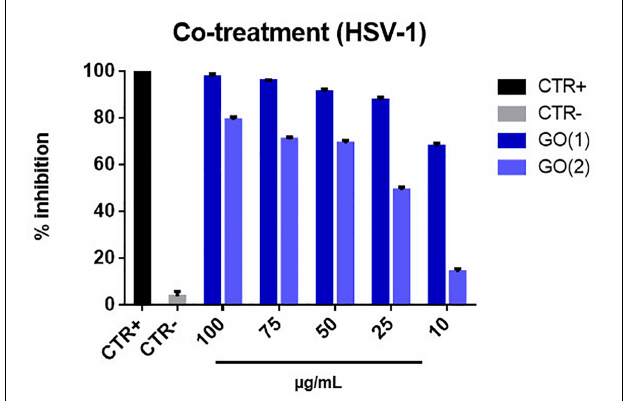
FIGURE 9 | Co-treatment with GO NSs. The graph shows the percentage of inhibition of viral infection after treatment with GO [GO(1) and GO(2)]. We remind that for GO(1) the average lateral size of the nanoflake is ≈ 175 nm whereas for GO(2) is ≈ 500 nm, the average thickness being ≈ 1.2 nm and ≈ 2.5 nm, for GO(1) and GO(2), respectively. Cells and cells infected with virus represented the positive and negative controls, respectively. The data statistical error is the standard deviation of three independent experiments. P -value is less than